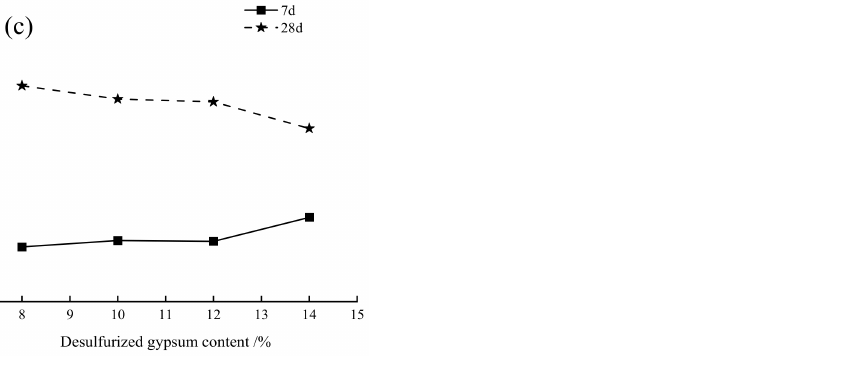
Figure 2. The relationship between the amount of each cementitious material component and the filling body strength: ( a ) fly ash, ( b ) clinker, ( c ) desulfurized